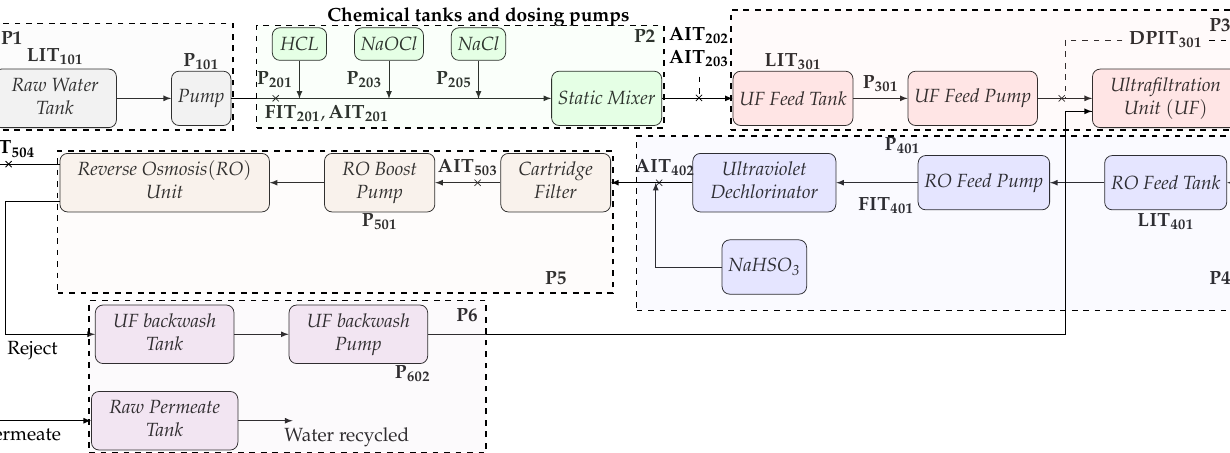
Figure 4. SWaT testbed processes overview [57].